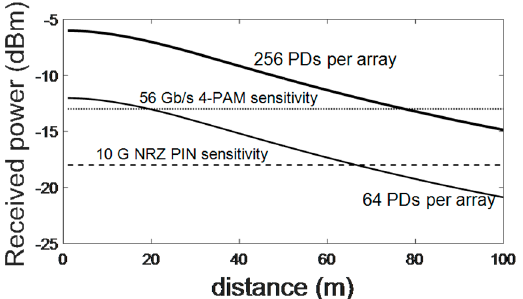
Figure 6. Transmission performance of the Optical Beam Steering systems (received power as a function of distance). The transmitted power out of chip is 5 dBm at 1300 nm, and the receiver contains 64 PDs or 256 PDs. In the plot, the sensitivity of the state of the art 4-PAM and 10 G systems using PIN PDs is also depicted (beam waist = 3 mm).